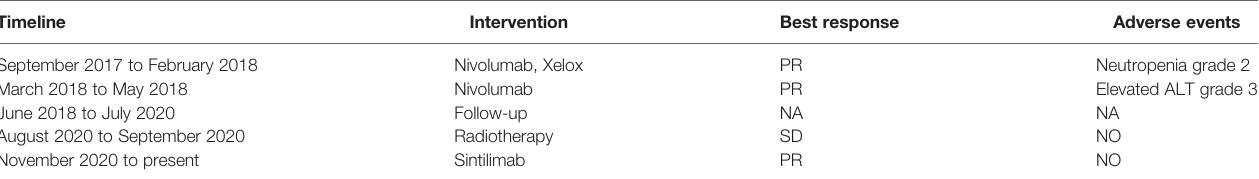
TABLE 2 | Timeline with relevant data during the